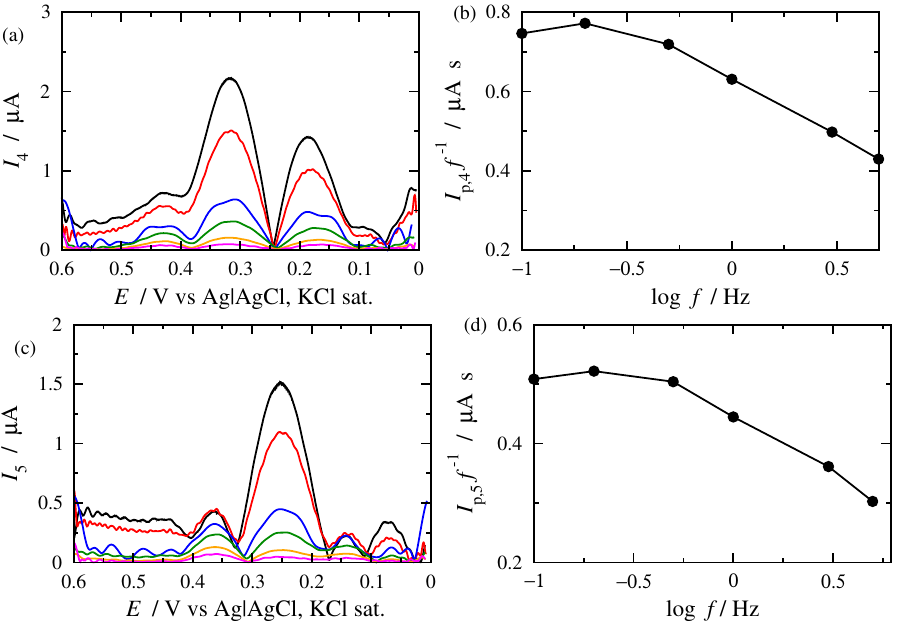
Figure 4. Experimental results: ( a ) 4th harmonics, ( b ) normalised peak height of the 4th harmonic, ( c ) 5th harmonics and ( d ) normalised peak height of the 5th harmonic, of Mt LPMO9H immobilised on a Co-f-MWCNTs modified GC electrode at 25 ◦ C. Experimental conditions: acetate buffer 500 mM, pH 6, A 0 = 0.2 V, and f = 5 (black), 3 (red), 1 (blue), 0.5 (green), 0.2 (orange) and 0.1 (magenta) Hz.